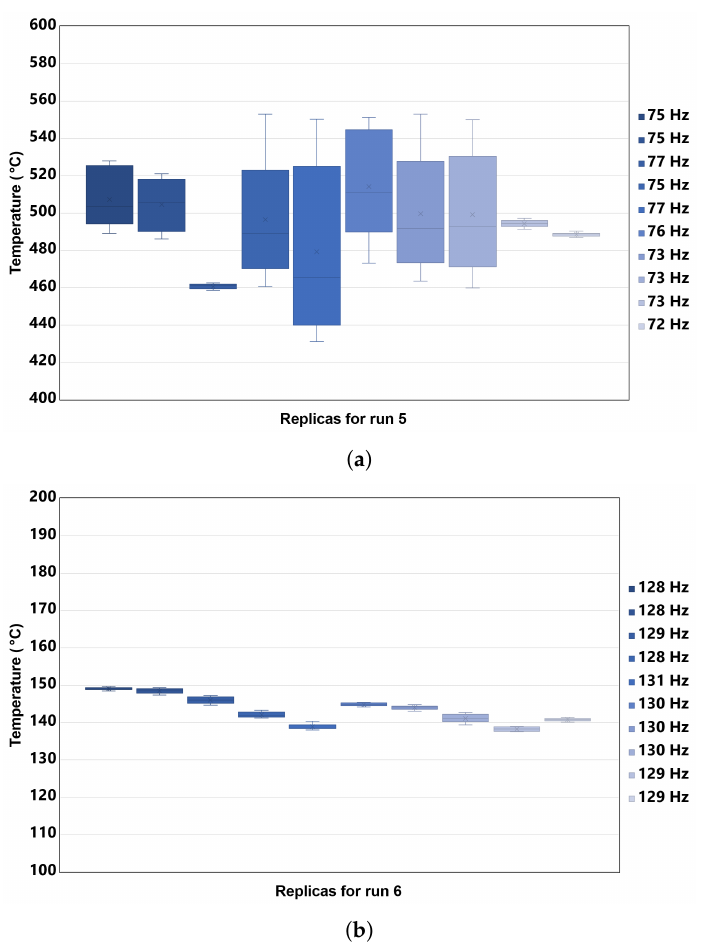
Figure 3. Measurements for runs 5 and 6: ( a ) Replicas of the nominal rotational frequency of 76 Hz with their temperature variability at the nominal temperature of 500 ◦ C; ( b ) Replicas of the nominal rotational frequency of 127 Hz with their temperature variability at the nominal temperature of 150 ◦